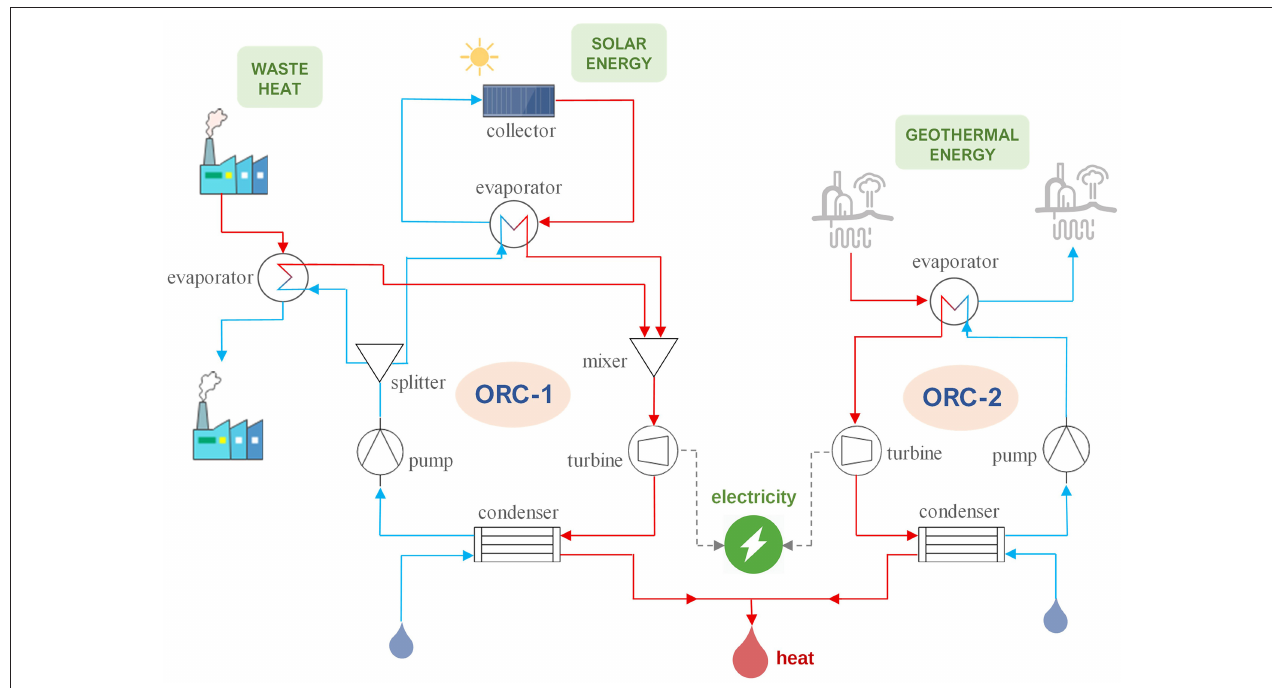
FIGURE 1 | Schematic representation of proposed